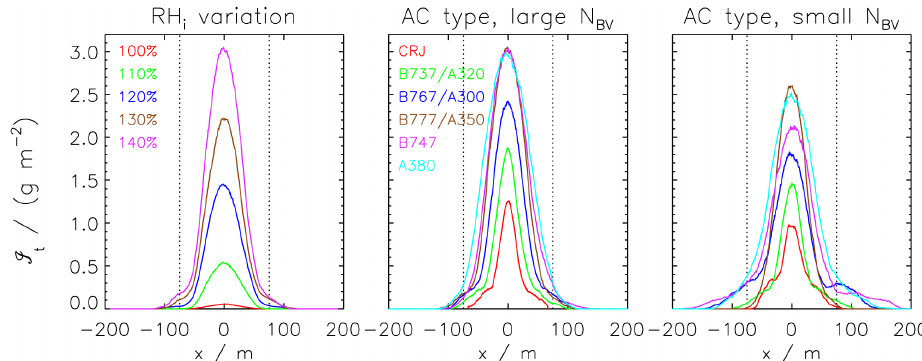
Figure 7. Transverse profiles of ice crystal mass for various simulation subsets. The profiles show ice water content integrated over the vertical direction and averaged along flight direction after 4min. The left panel shows a RH i variation for a B777-type aircraft; the middle/right panel shows a variation of aircraft type for strong/weak stratification ( N BV = 1 . 15 × 10 − 2 and 0 . 5 × 10 − 2 s − 1 ) at RH i = 120%. The simulations are listed in Block 1, 2 and 3 of Table A2, respectively. The dotted vertical lines indicate the W = 150m approximation.